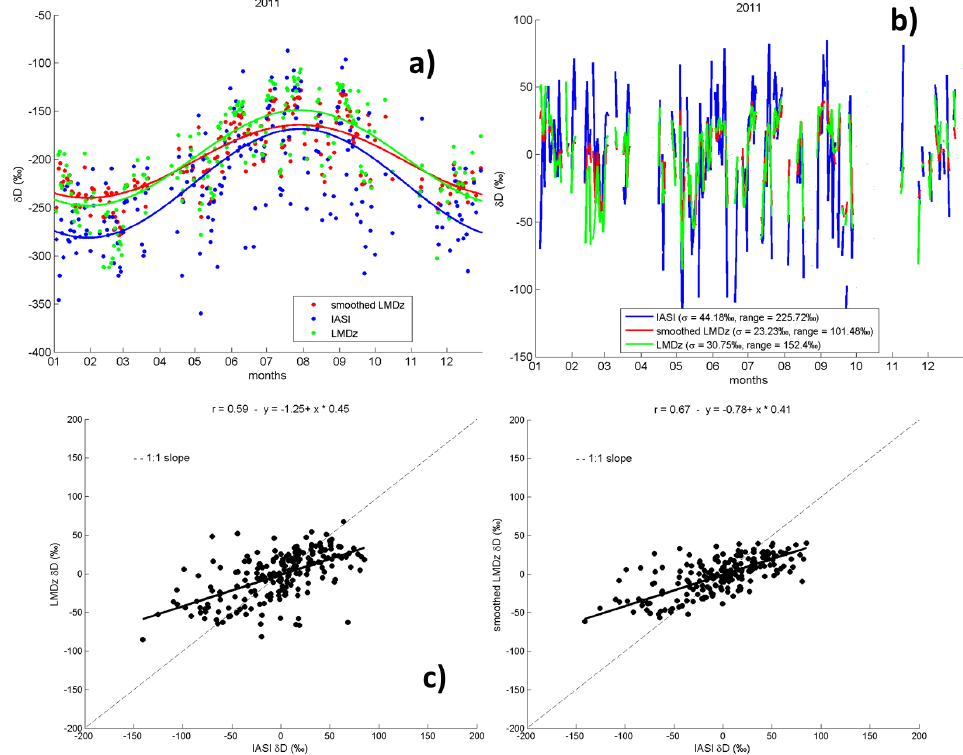
Figure 10. (a) Daily [0–3km] δ D means for IASI (blue), smoothed LMDZ-iso (red) and LMDZ-iso (green) with their seasonal trend (curve) in 2011 with a | 1T | > 8K. This seasonal fit is defined as: δ D = ¯ δ D + SD( δ D) × cos ( 2 π obtained by subtracting daily means time series by the seasonal fit. (c) Scatter plot between the deseasonalized daily mean data (left: LMDZ- iso vs. IASI, right: smoothed LMDZ-iso vs. IASI). The dashed line corresponds to the theoretical 1 : 1 slope and the black line corresponds to the linear regression.